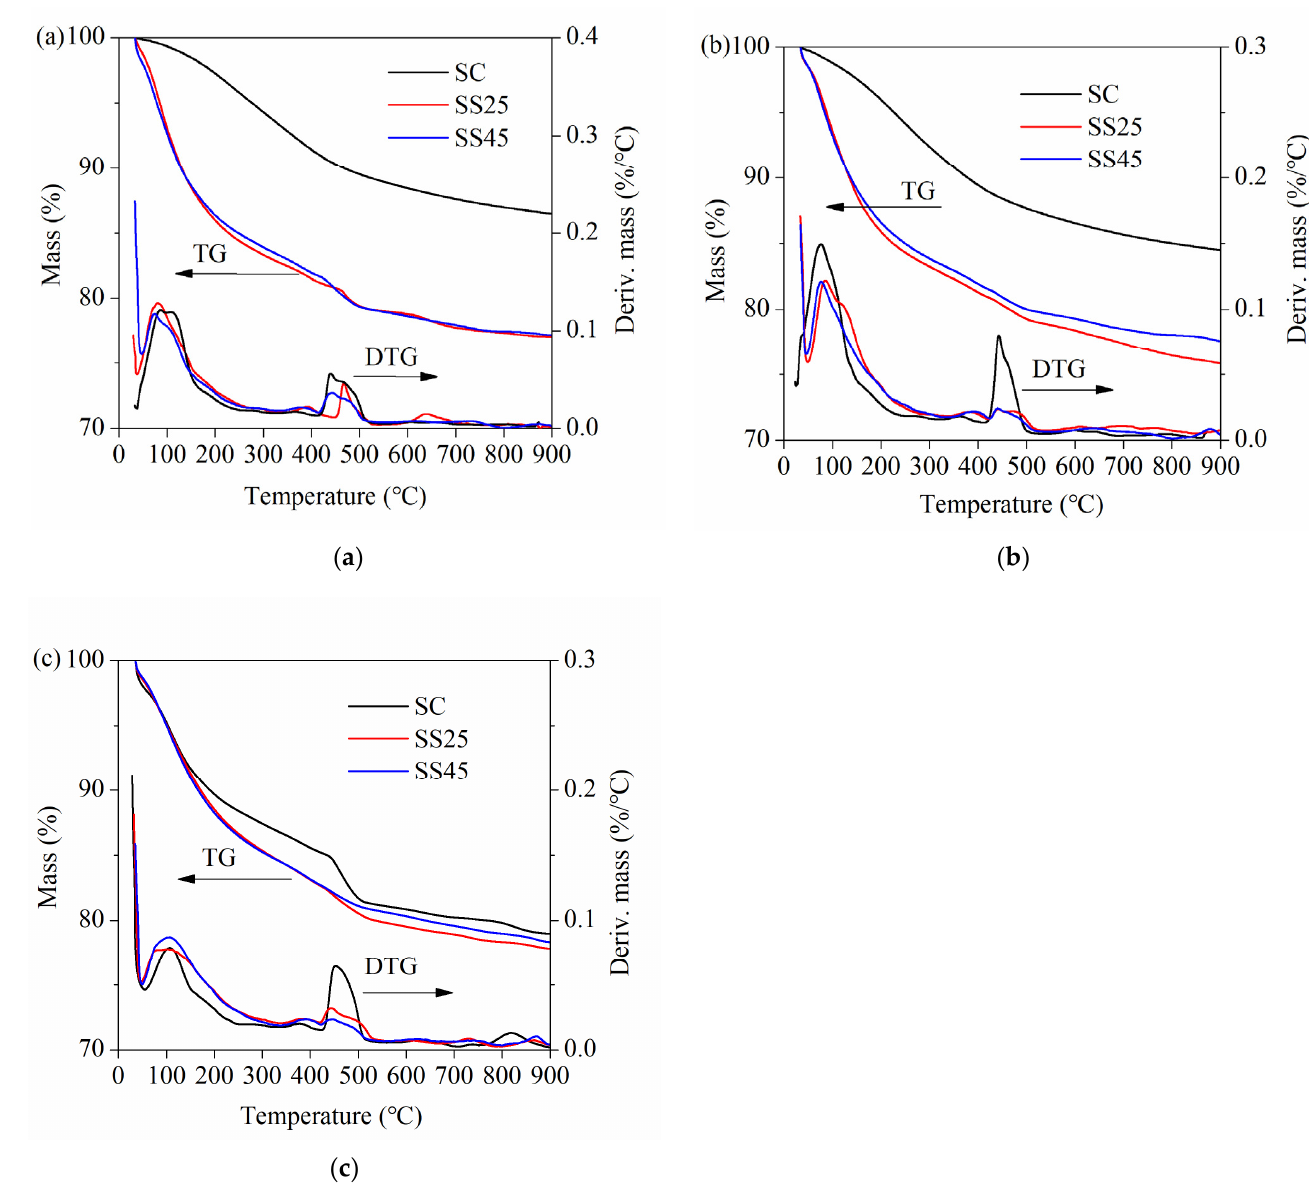
Figure 10. Thermogravimetric (TG) and derivative thermogravimetric (DTG) curves of hardened pastes under standard